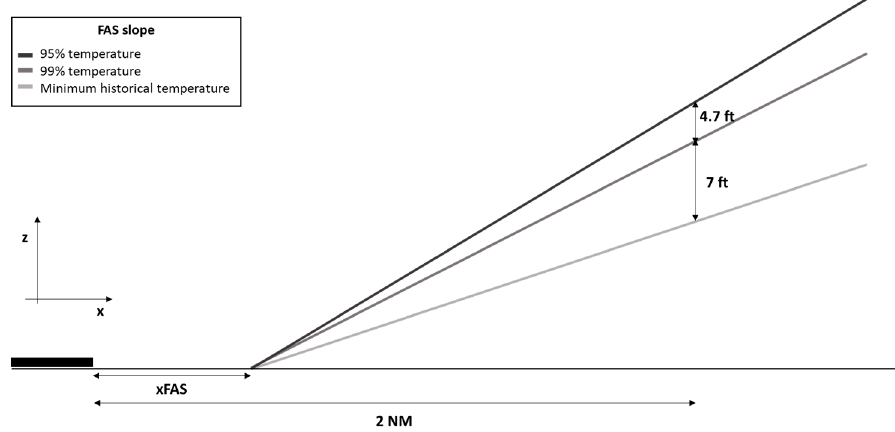
Figure 9. FAS slope for different temperatures.